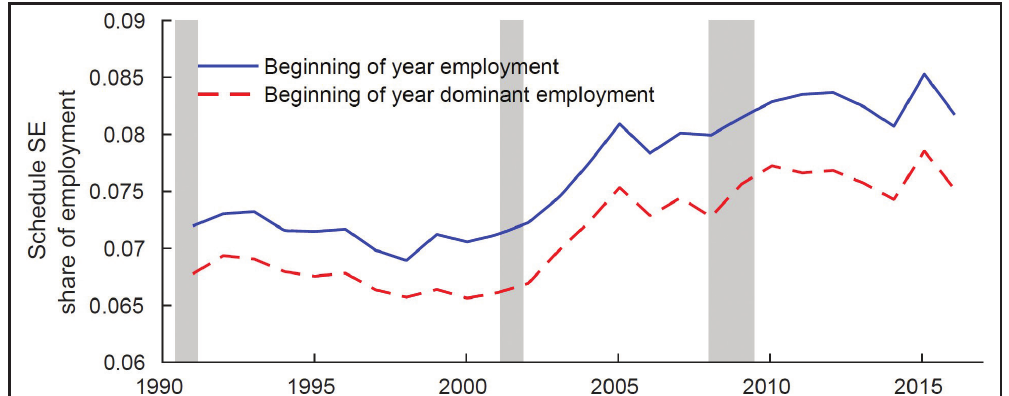
Figure D1 Schedule SE share of total consecutive-year